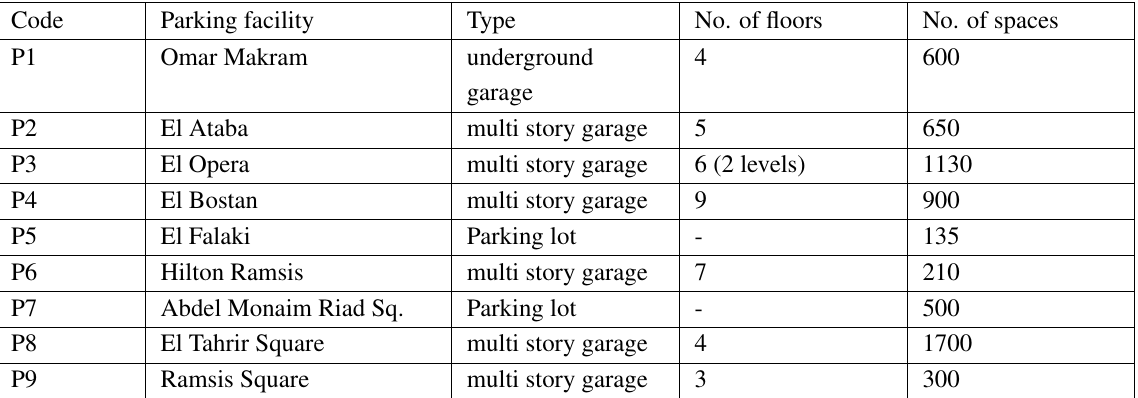
Table 7. Parking spaces in the study area (EEAA, 2018)